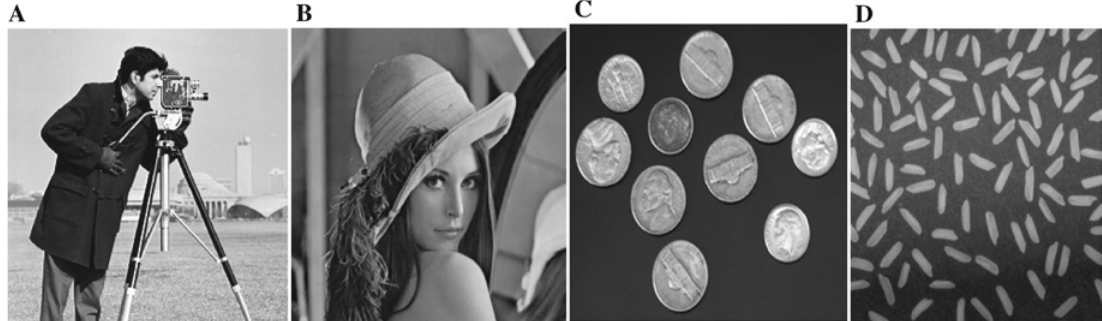
Figure 1: (A–D) Image Data